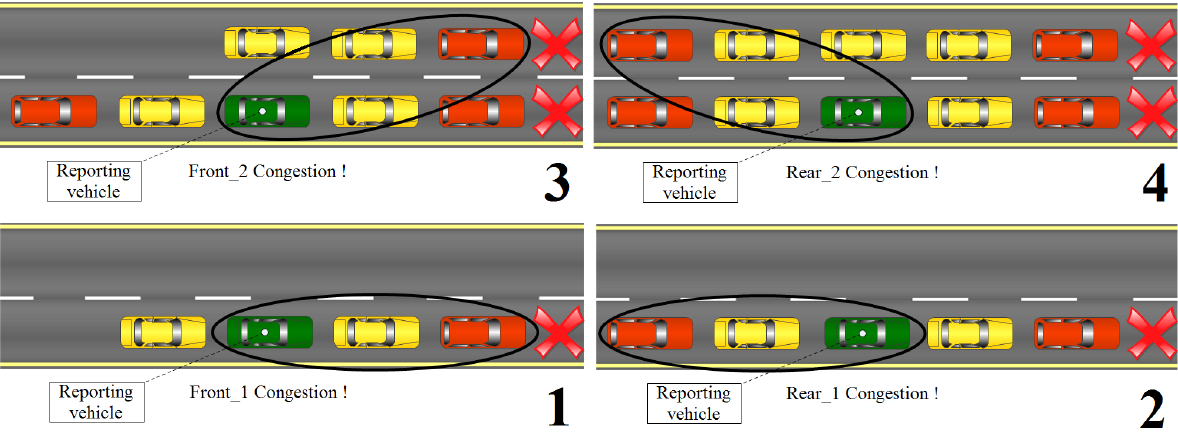
Figure 6. Road congestion reporting